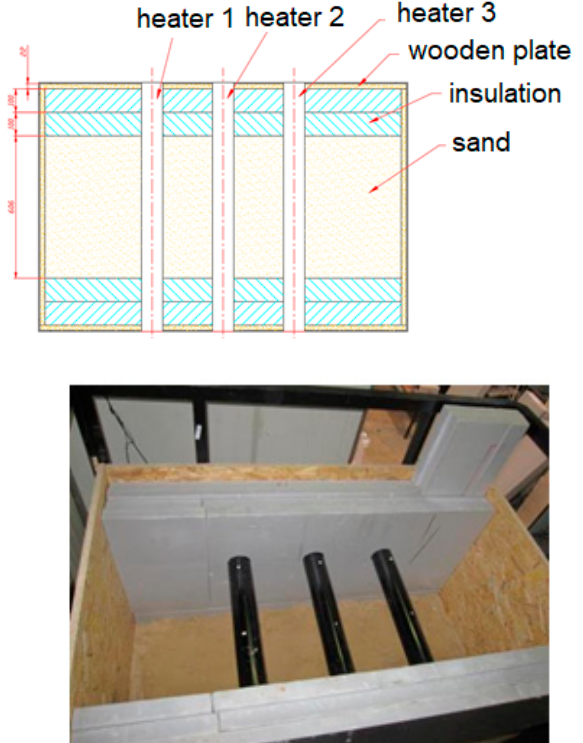
Figure 2. Placement of power cables in the sand.